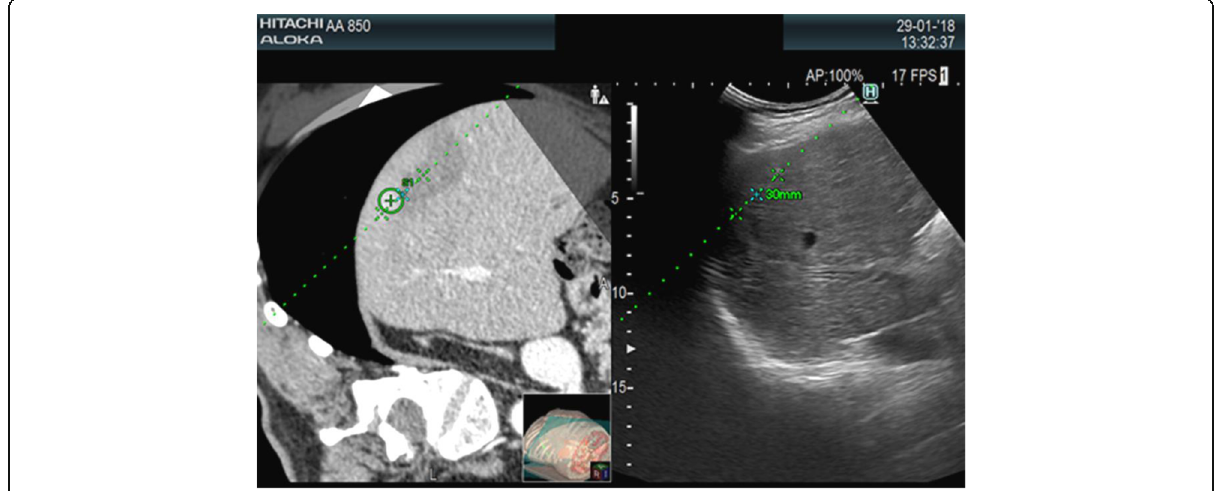
Fig. 1 CT-US fusion imaging. Treatment of very small hypervascular nodular recurrence of HCC adjacent to a previously ablated